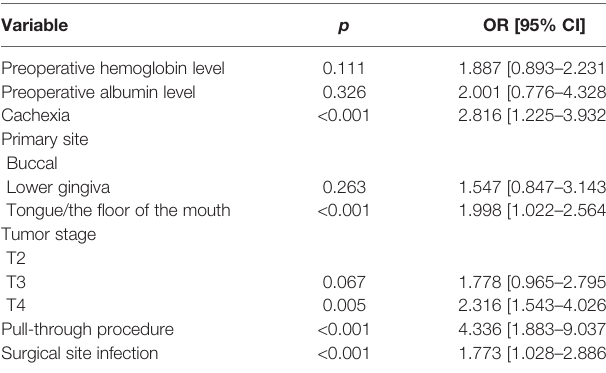
TABLE 3 | Multivariate analysis of the association between clinicopathologic variables and orocutaneous fi stula (OCF)